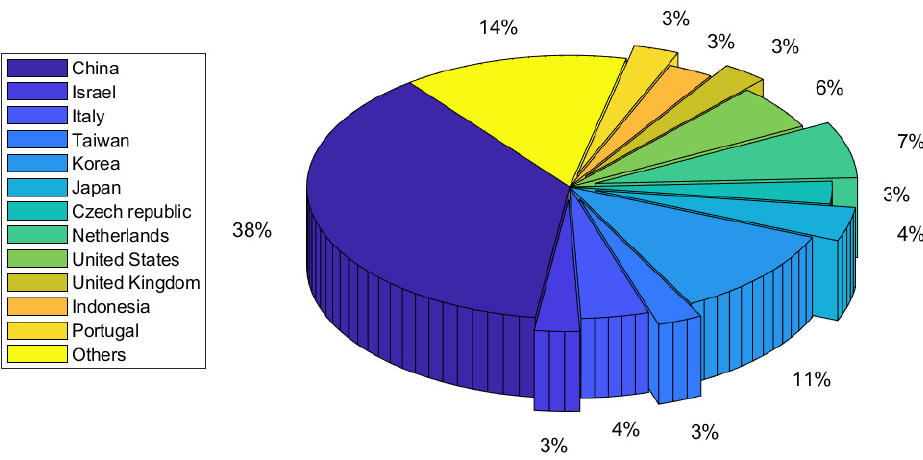
Figure 8. Country-wise distribution of the reviewed papers in controlled environment